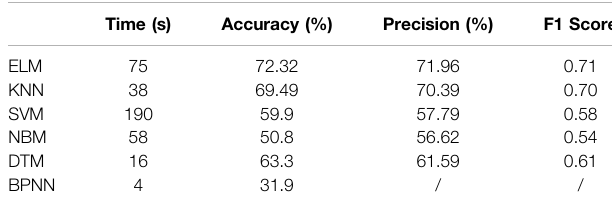
TABLE 2 | Comparison of method